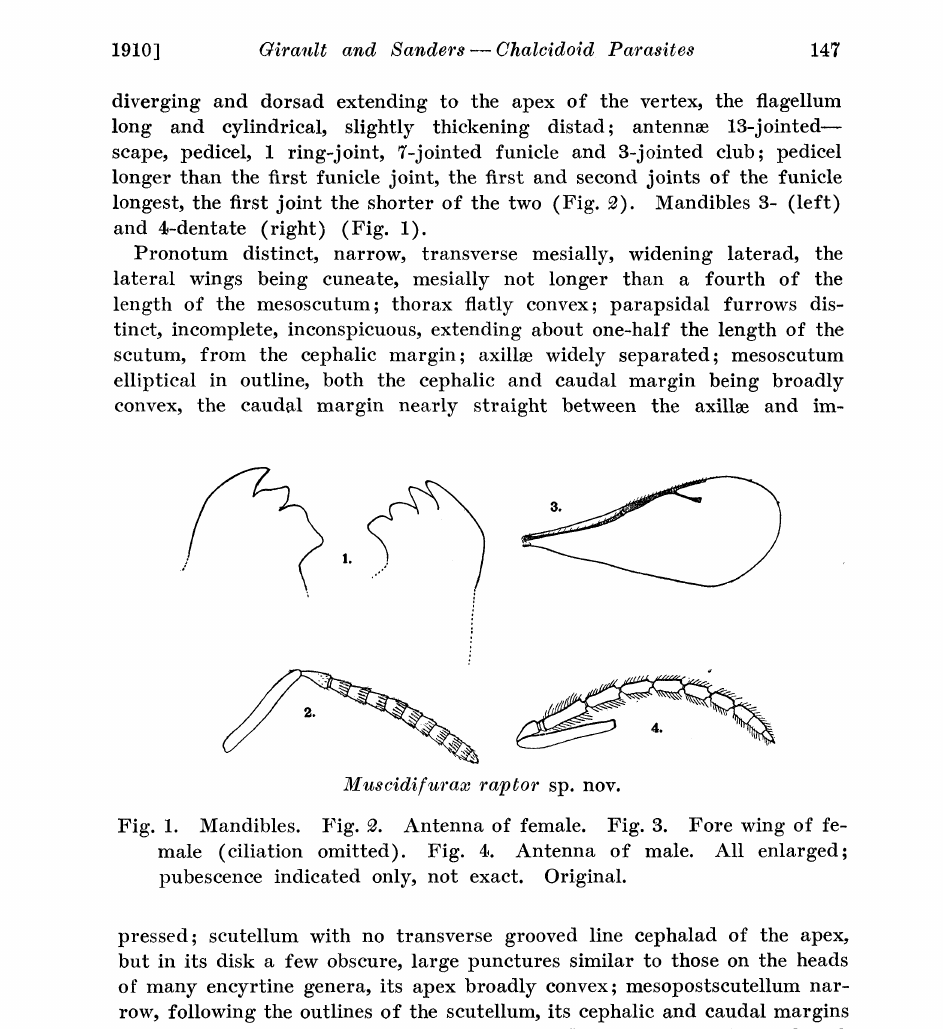
Fig. 1. Mandibles. Fig. 2. Antenna of female. Fig. 3. Fore wing of fe- male (ciliation omitted). Fig. 4,. Antenna of male. All enlarged pubescence indicated only, not exact.